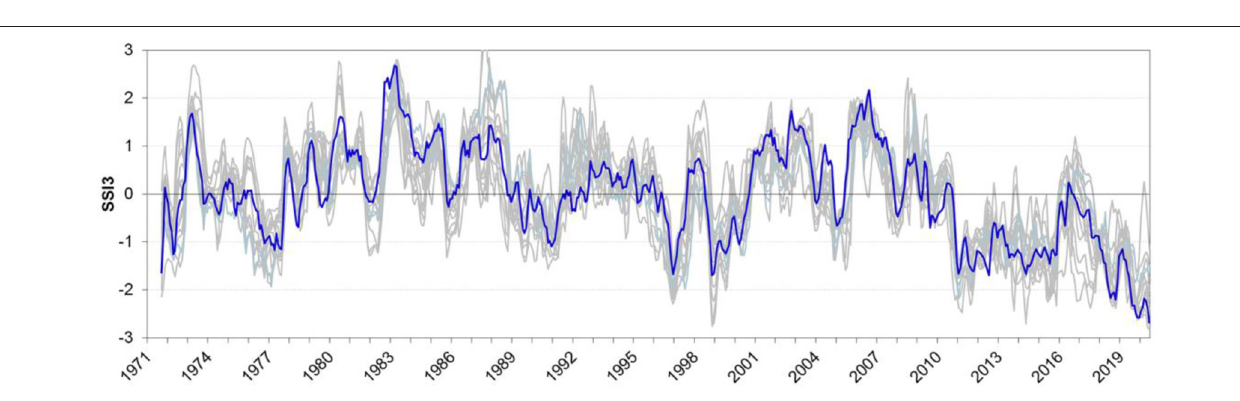
FIGURE 6 | Regional time series of the ANDD (A) and the ACDV (B) for the three selected threshold levels during 1971/72-2019/20.